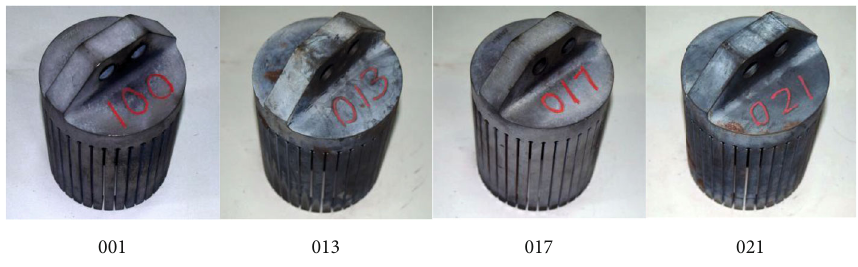
Figure 13: The fi nger locks used in the experiment.